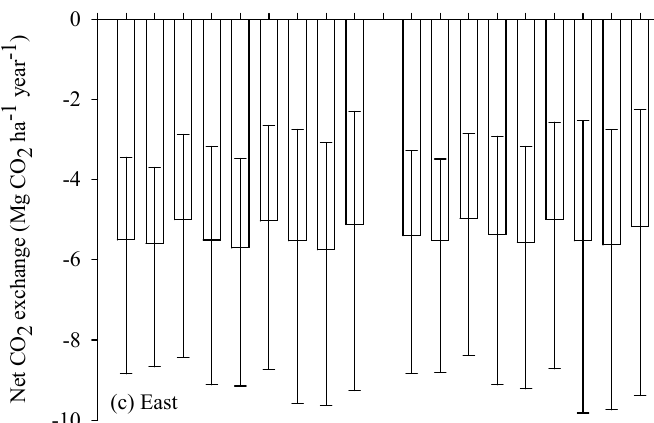
Figure 6. Annual net CO 2 exchange (Mg CO 2 ha − 1 year − 1 ) using default displacement factors over the 40-year period for different management scenarios and under three different harvest intensities including timber (T), timber and logging residues, without (BN) and with coarse roots and stumps (BNR) in the final felling made at DBH of 26 cm and 22 cm in southern ( a ), western ( b ) and eastern ( c ) sub-regions of Finland. Upper cap (lowest value) and lower cap (highest value) shown in the bar represent for doubling and lowering the default displacement factors. For the key of the management scenarios, see Table 1.